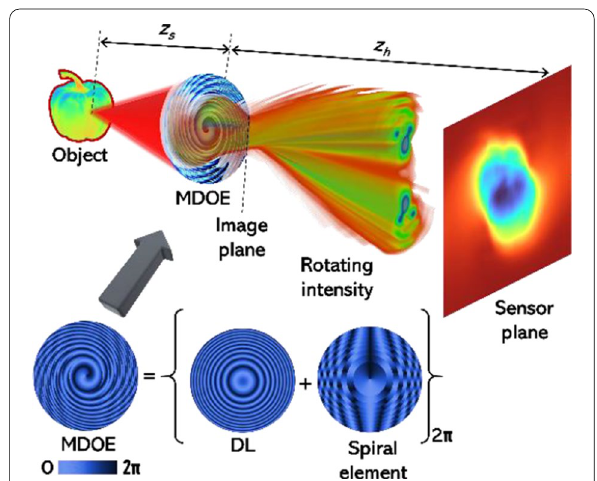
Fig. 1 Optical configuration of 3DI 2 SB and generation of phase distribution of the MDOE from a lens and spiral